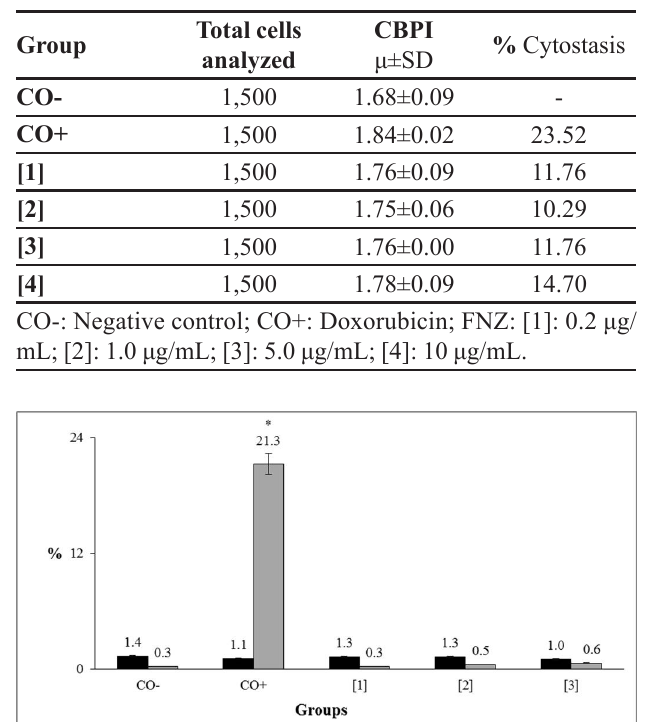
TABLE I - The mean cytokinesis block proliferation index (CBPI) of 1,500 control cells compared with cells that were treated with flunitrazepam